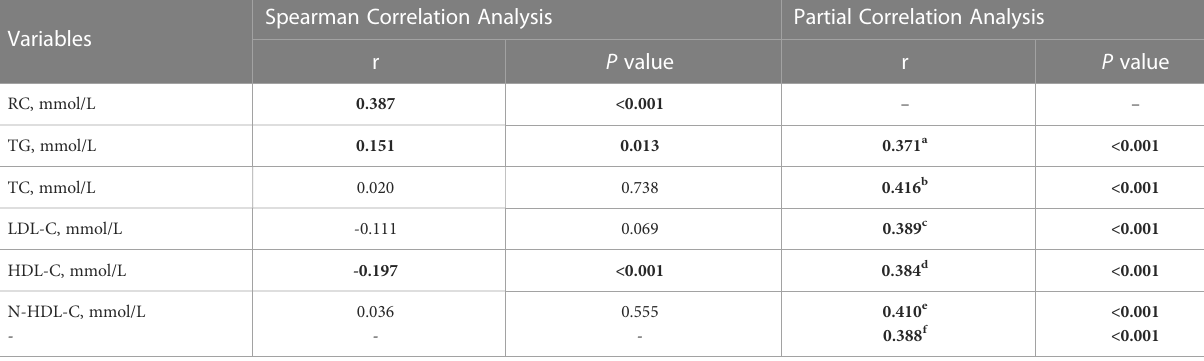
TABLE 3 The correlation between stages of T2DM – PAD and the following lipid pro fi les.